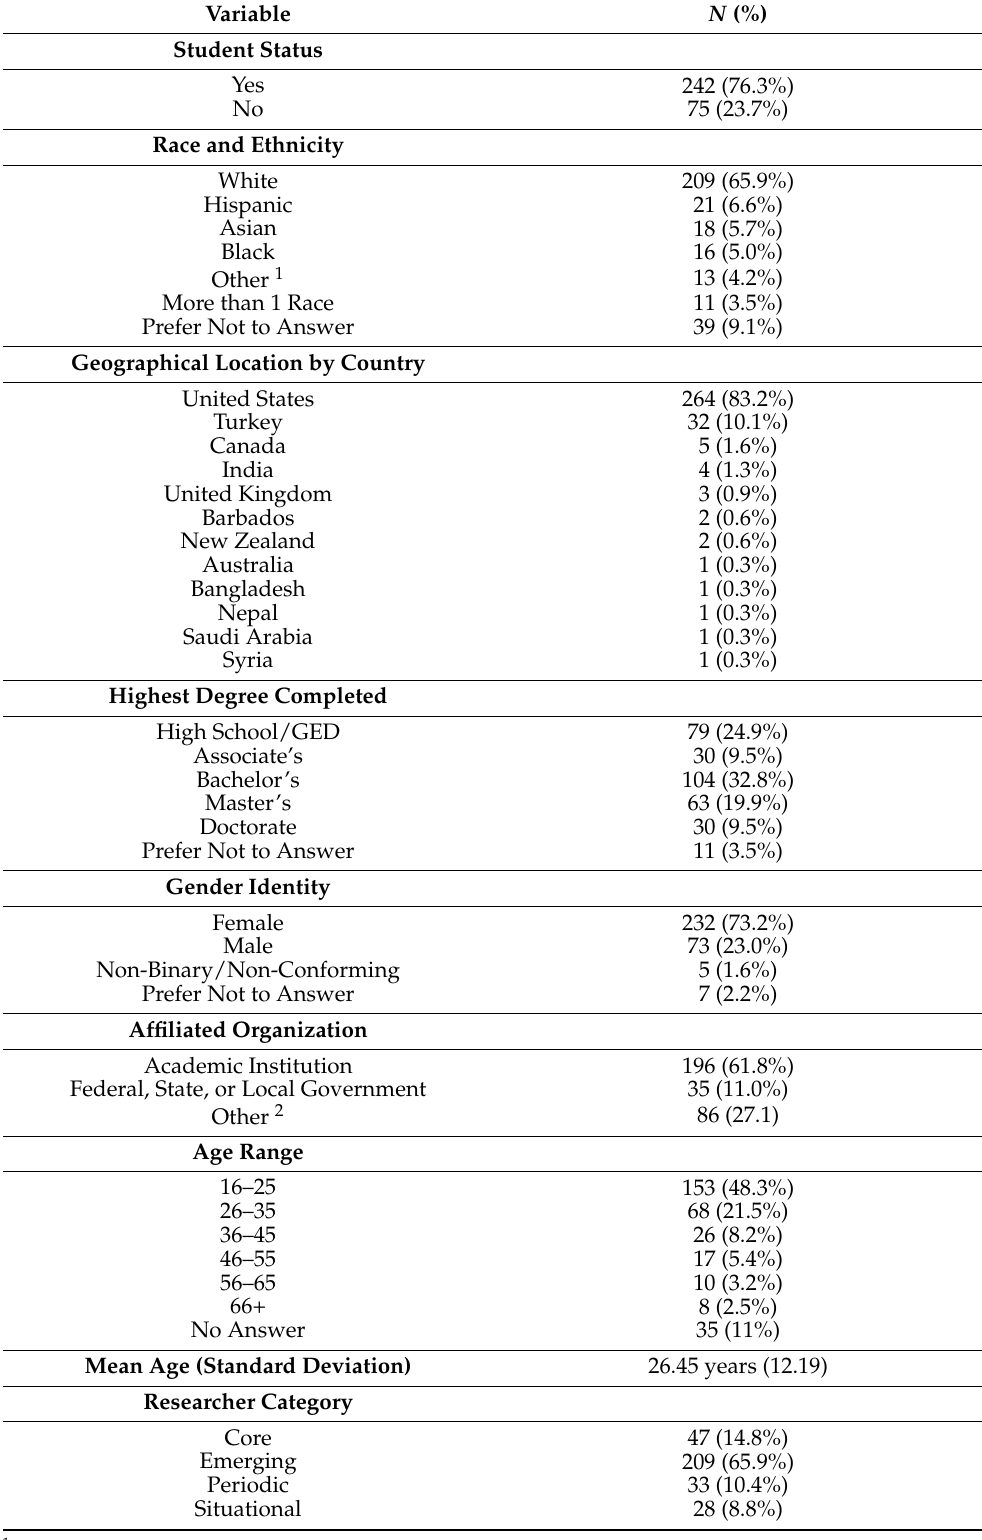
Table 1. Sociodemographic Characteristics of CONVERGE Disaster Mental Health Training Module